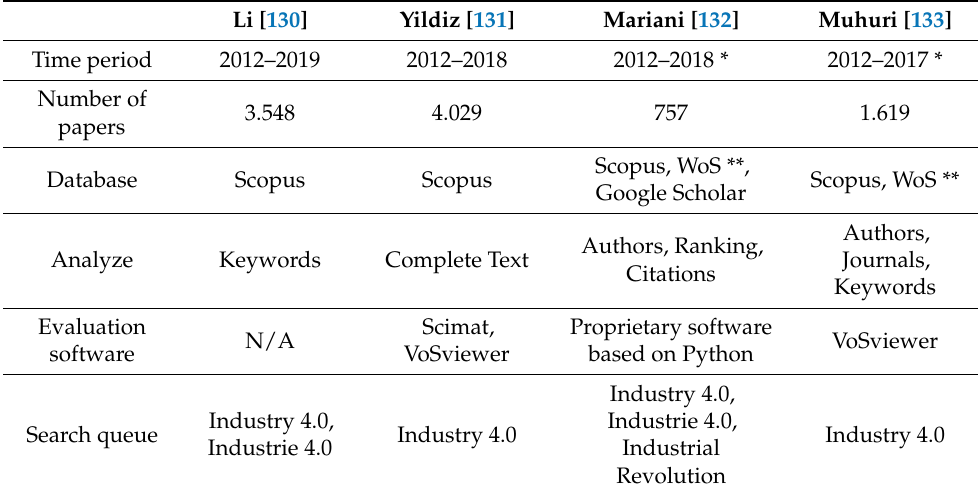
Table 1. Approaches of bibliometric analysis within the scope of the literature research. Li [130] Yildiz [131] Mariani [132] Muhuri